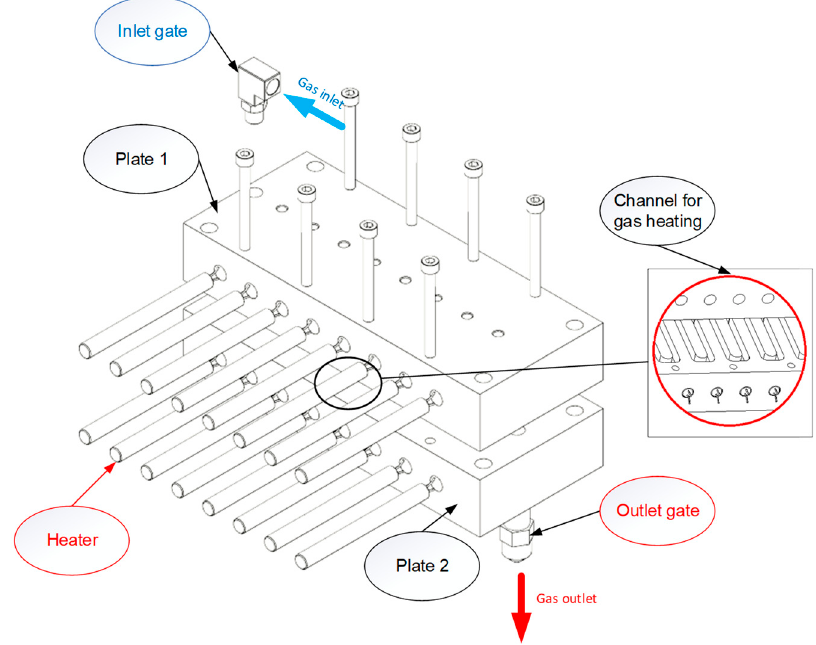
Figure 4. The hot-gas generator.